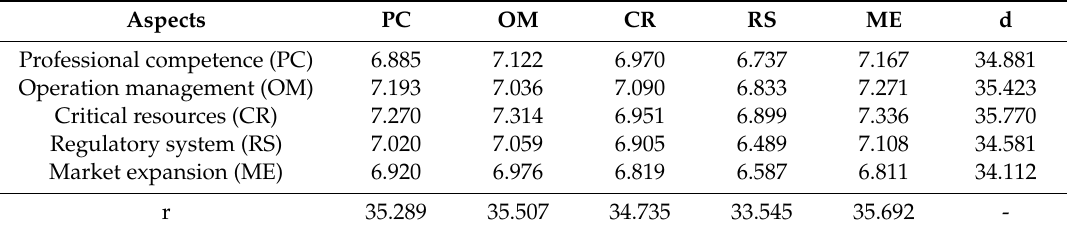
Table 8. The full influence matrix (T).